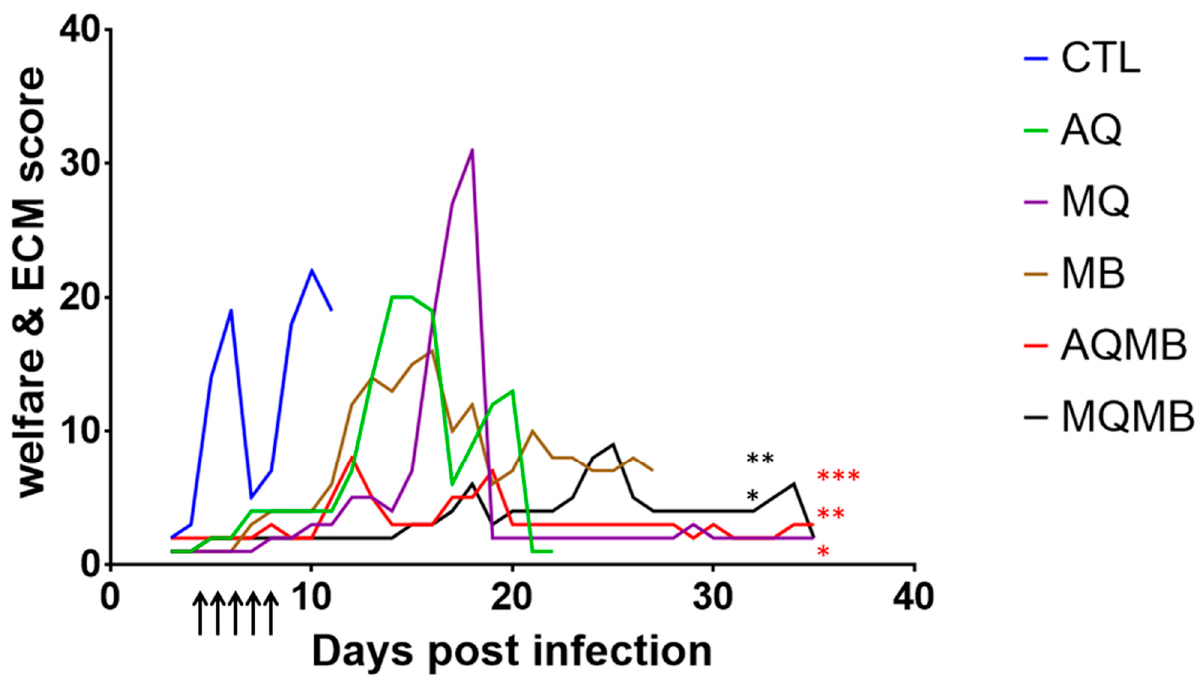
Figure 4. ECM score evolution. The ECM score was evaluated from D3 to D35 for all therapeutic groups. In blue, Control (CTL) with saline solution for five days. In green, AQ 5 mg/kg for three days. In purple, MQ with 5 mg/kg for three days, In brown, MB with 10 mg/kg for five days. In red, MB with 10 mg/kg for five days associated with AQ 5 mg/kg for three days (AQMB). In black, MB with 10 mg/kg for five days associated with MQ 5 mg/kg for three days (MQMB). Black arrows indicate days of treatment. A score below 4 indicates normal clinical status for mice. * = significant versus CTL, ** = significant versus MB, *** = significant versus AQ. Asterisk in red for AQMB and in black for MQMB.